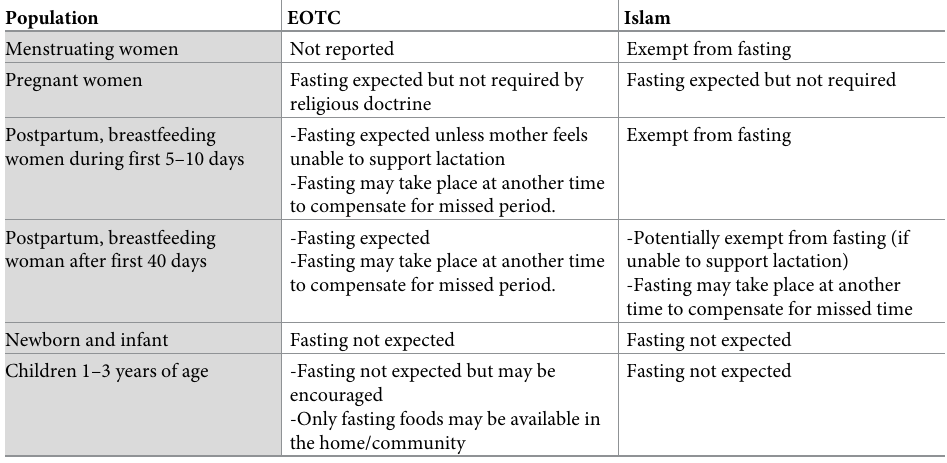
Table 2. Fasting practices reported by participants in 4